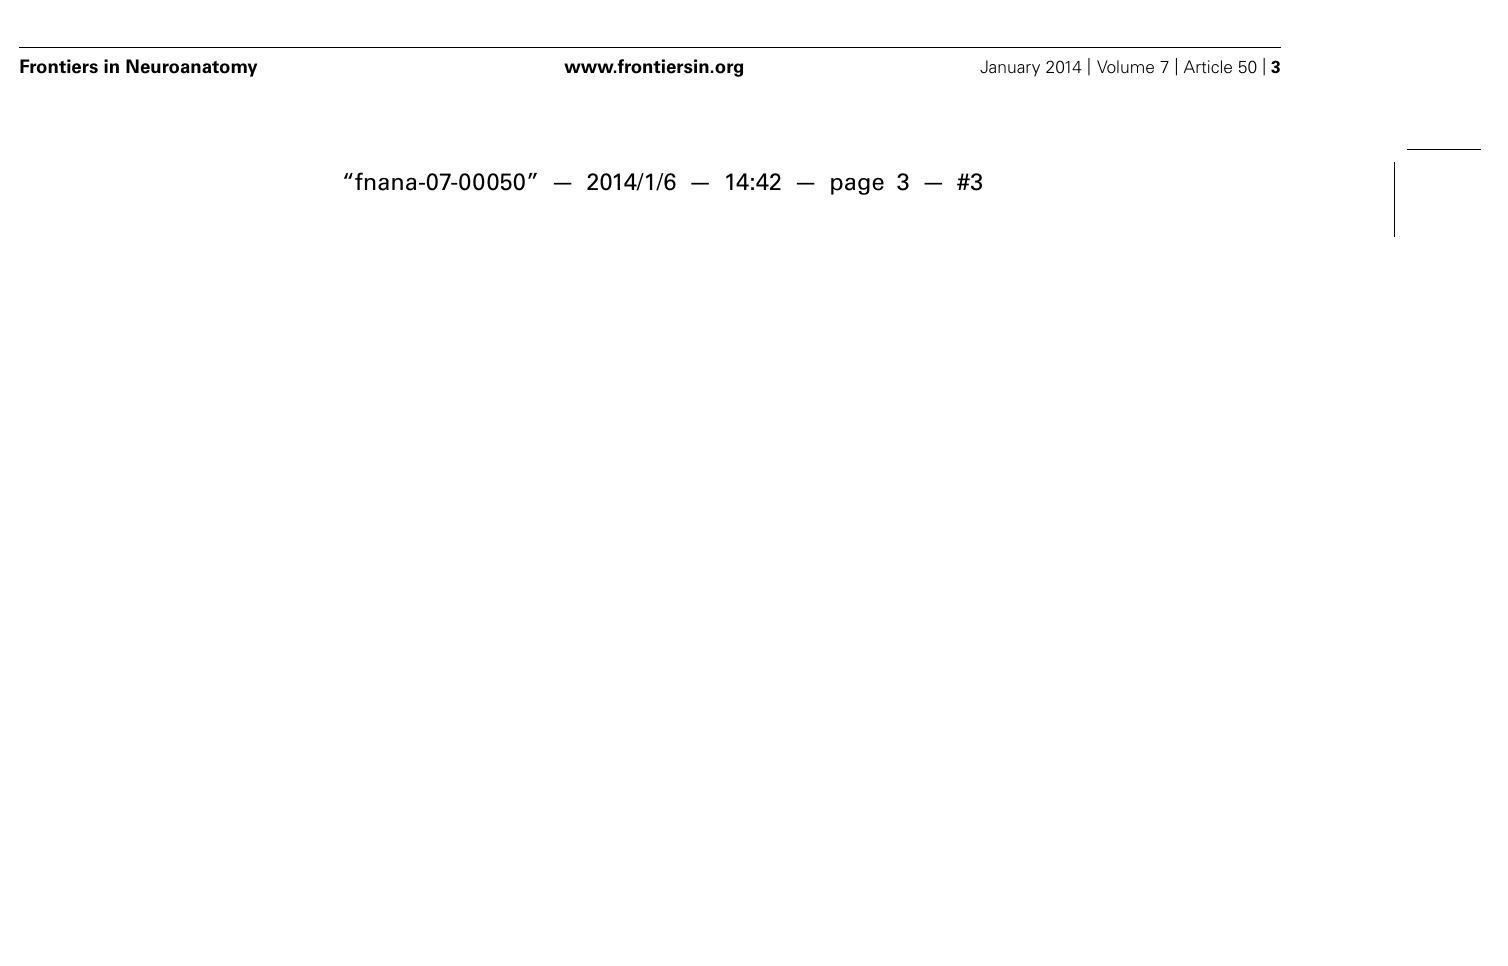
clones (note 9.8 kb band). (C) Western blot immunostained with an anti-GFP Ab. Adult forebrain (Br) and cerebellar (Cbl) lysates were gel-separated as indicated. Lanes 1–4 contain lysates from Rosa26 EGFP − VAMP 2 / + mice, revealing a 49 kDa band corresponding to the size of the EGFP-VAMP2 fusion protein; lane 5 contains lysates from Rosa26 YFP / + mice (27 kDa). Lanes 1 and 4 are from Syn1-Cre negative mice; Lanes 2, 3, and 5 are from Syn1-Cre positive